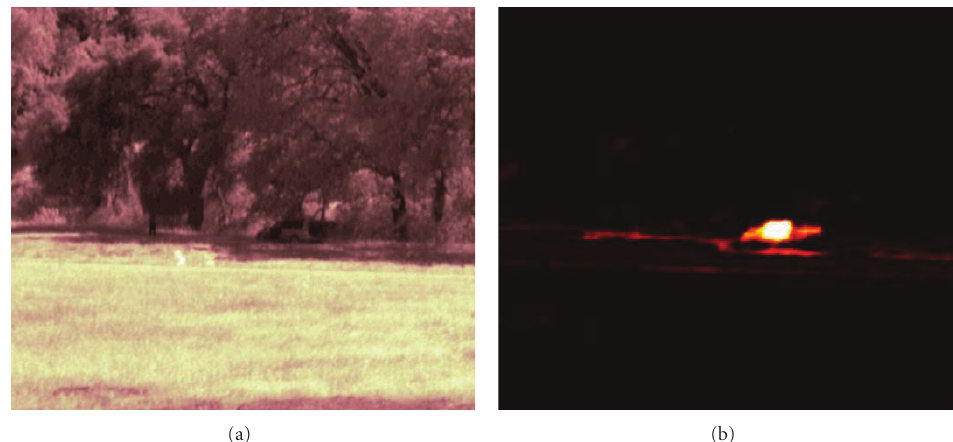
Figure 10: Results testing Cube 3 (a) and corresponding output surface (b). Parameters were set to ( q = 0 . 10; T 1 = T (20); N = 22; M = 40). A motor vehicle is parked in tree shades—around center of the scene. Using the available ground truth information of the scene, the white clusters cover about 73% of the motor vehicle’s spatial area and no false